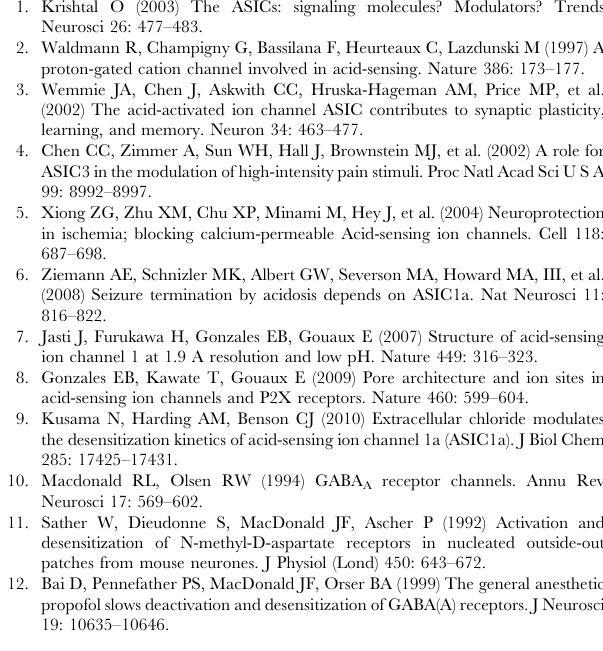
Figure S7 A working model of interaction of ASICs with GABA A receptors. In the resting states (top), GABA A receptors do not intervene with the function of ASICs. When GABA A receptors are opened (bottom), part of receptors that locate close to ASICs may interact with the open ASICs and thereby modify ASIC functions. This interaction may be conformation-dependent. It is unknown whether the chloride ions (red circles) bound in the extracellular thumb domains of ASICs participate in the interaction. GABA A receptors may not affect ASICs if two receptors locate distantly.